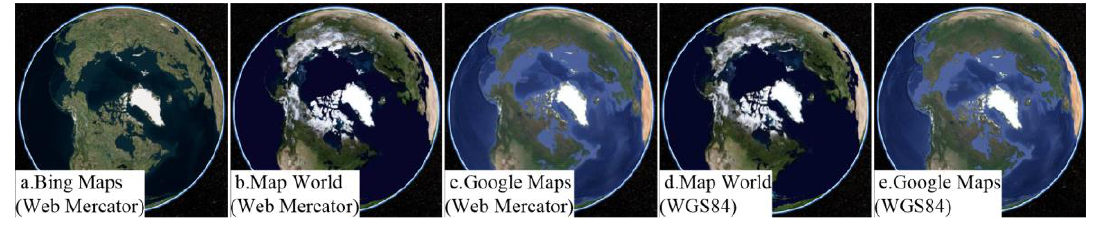
Figure 2. Tile loading effect with a single data source in 3D view